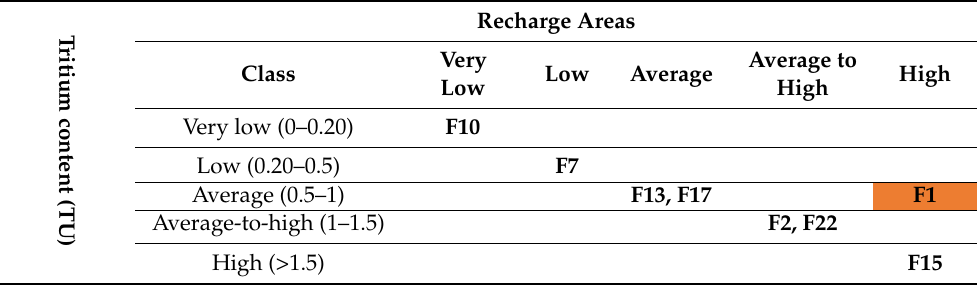
Table 8. Correspondence matrix between tritium contents and recharge areas.